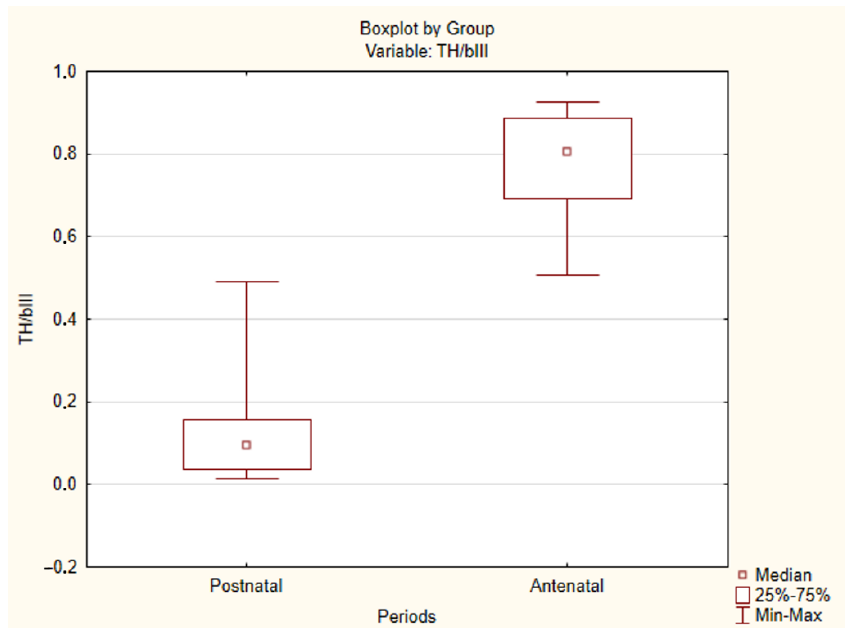
Figure 6. TH/ β III ratio in the antenatal and postnatal human carotid body. Statistically significant differences ( p < 0.05).